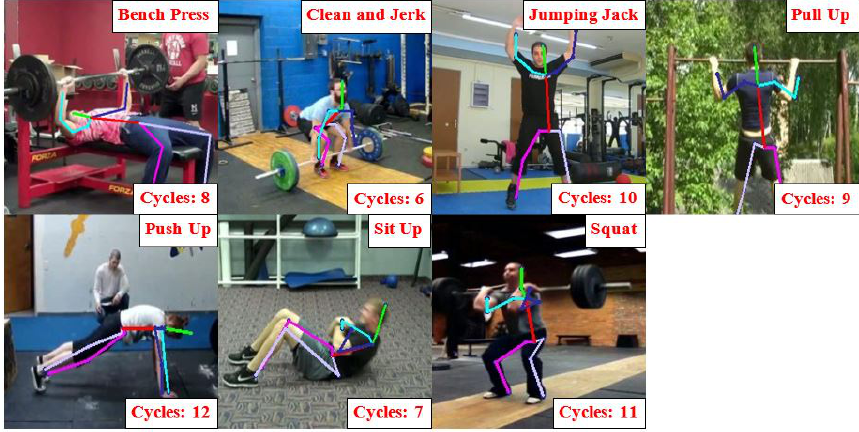
Figure 8. Examples of output frames. It includes all the 7 exercises with various